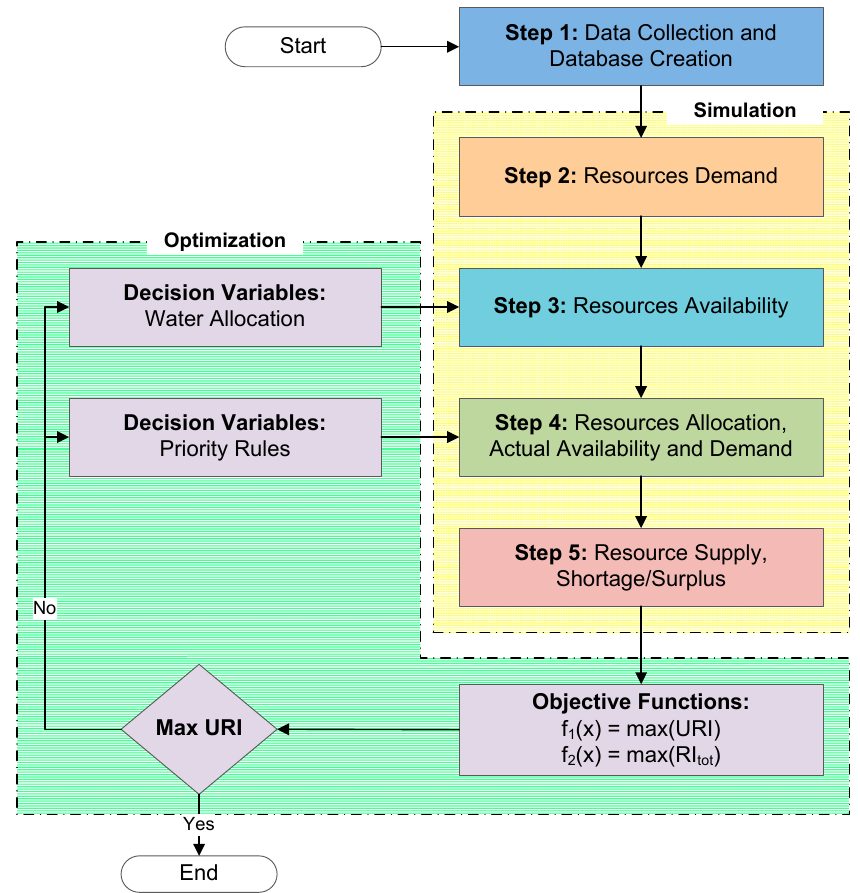
Figure 3. Optimization steps of WEFSiM ‐ opt.